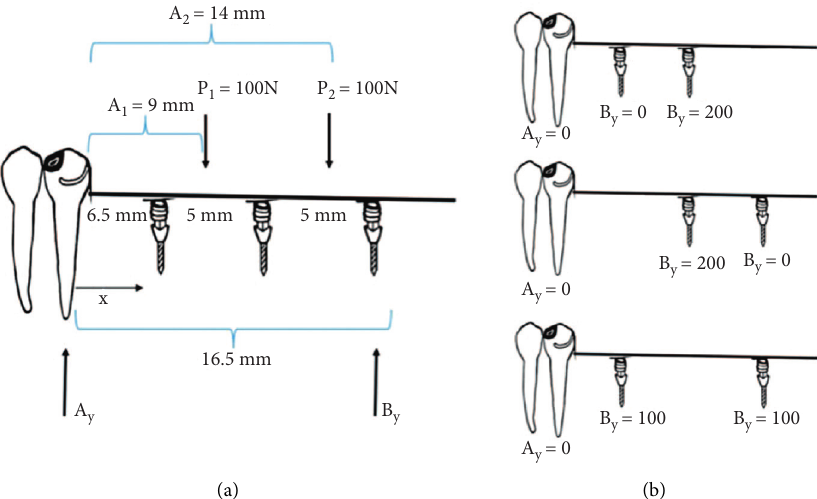
Figure 7: Diagram of the bending moment calculation. (a) represents action force and the distance between the abutment tooth and dental implant. A y denotes the action force on the abutment tooth. B y denotes the action force on the dental implant. (b) Diagram of loading on abutment and dental implant with 2 assisted dental implants on removable partial denture.